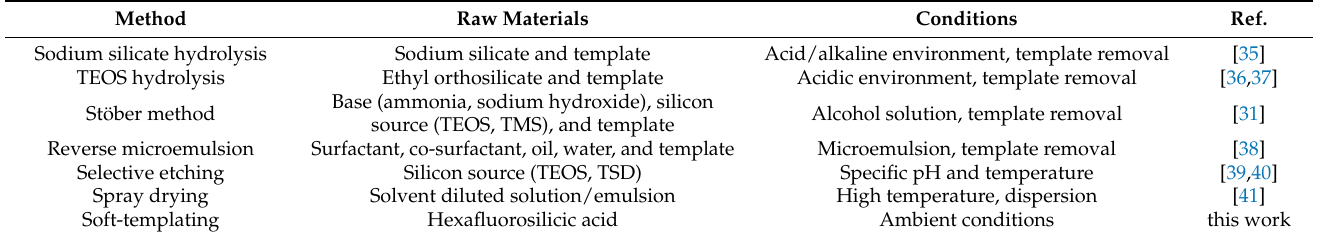
Table 1. Comparison of various methods to synthesize spherical shell/porous silica.